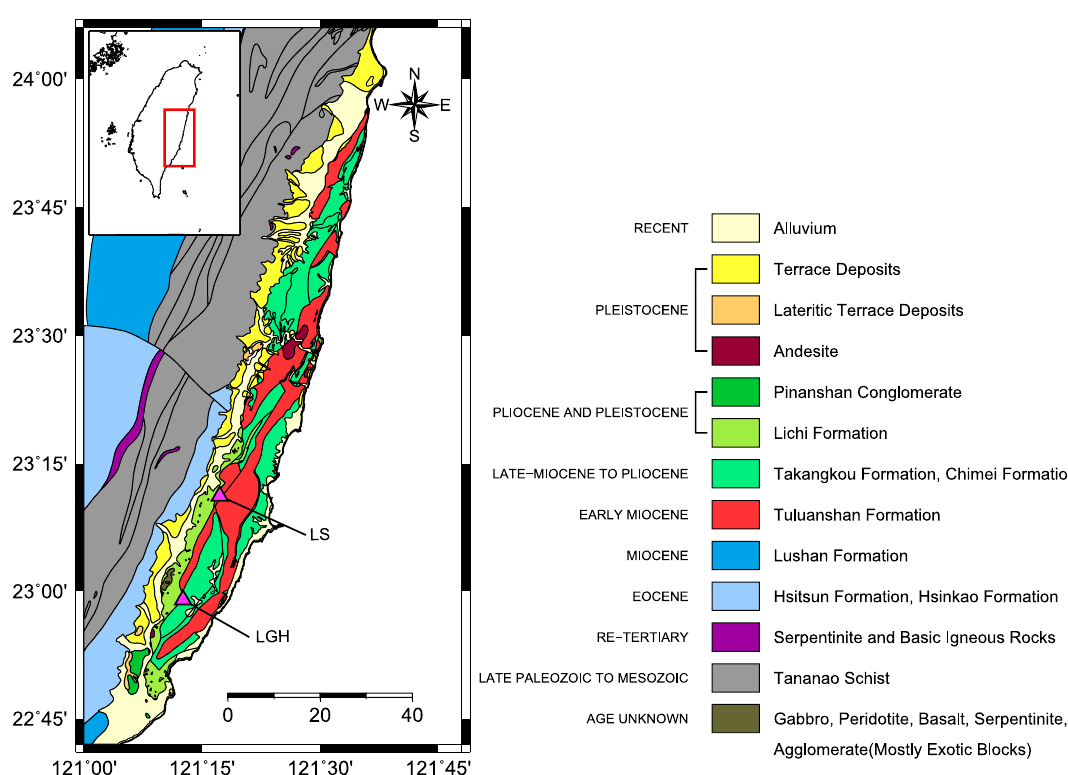
Fig. 2 Geologic map adopted from Central Geologic Survey, MOEA, Taiwan (www. moeac gs. gov.